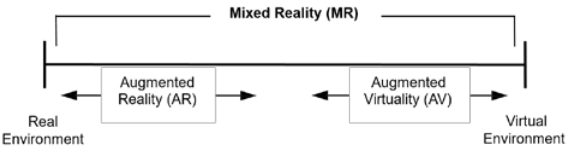
Figure 8. Milgram's reality-virtuality continuum